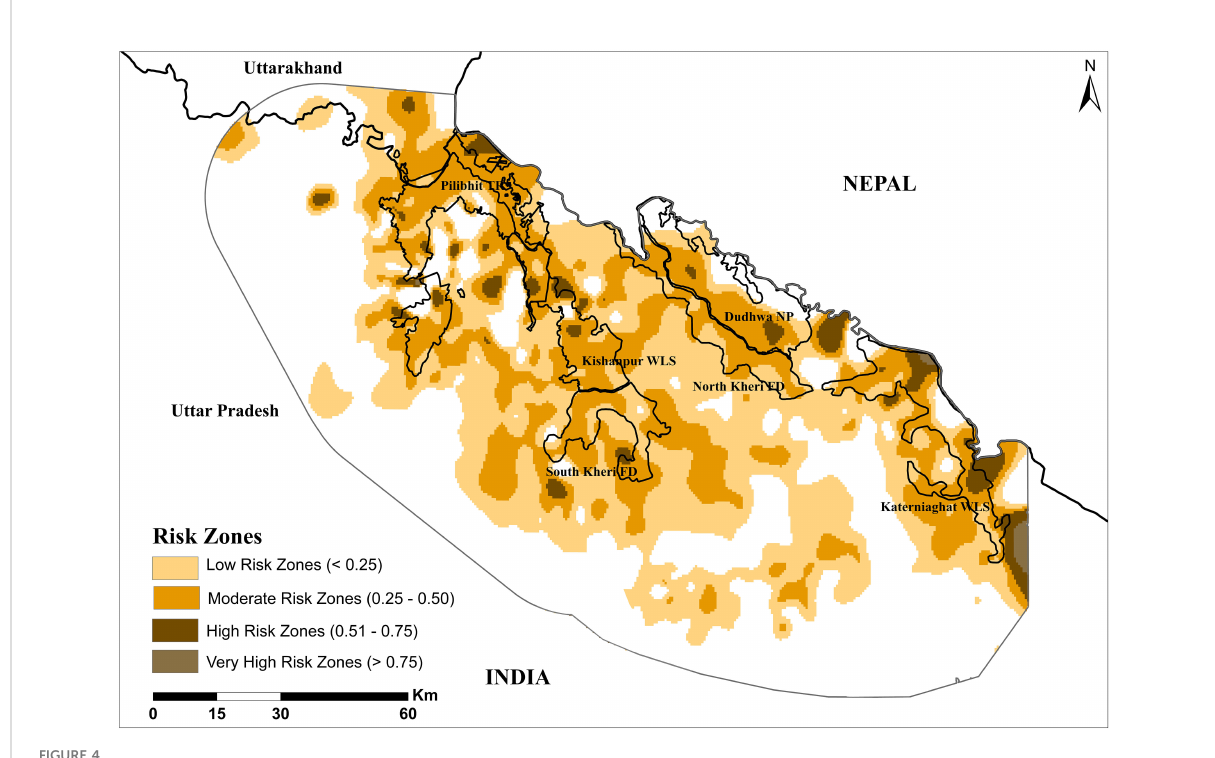
FIGURE 4 Risk zones of tiger attacks on humans in our study